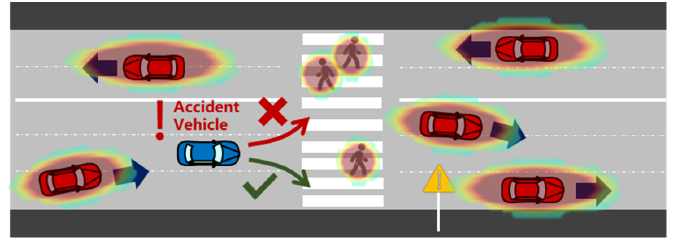
Figure 7. Regional differences for accident vehicles in emergency scenarios.